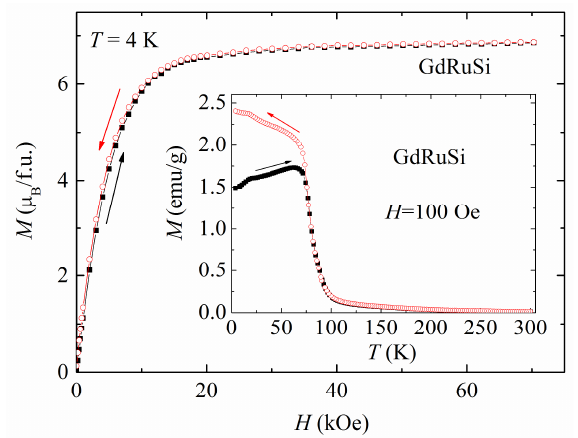
Figure 2. Magnetization and demagnetization curves of free powder sample of GdRuSi at T = 4 K. The inset shows field-cooled (FC) and zero-field-cooled (ZFC) thermomagnetic curves of GdRuSi collected in an applied field of 100 Oe applied along easy magnetization axis of the free powder sample. The zero-field-cooled thermomagnetic curve ZFC M(T) for the GdRuSi compound measured in a field of 100 Oe on free powder sample previously oriented along easy mag- netization axis by an external field of 70 kOe is presented in Figure 2. The increase in ZFC M(T) upon heating from 4 K can be caused by domain-wall movement [26]. Such an in- crease in field-cooled FC M(T) was not observed when cooling the sample in a field of 100 Oe (see Figure 2) because the maximum order degree for that magnetic field has already been reached [26]. There is no thermal hysteresis о n the M(T) dependence for GdRuSi in the region of the temperature of the magnetic phase transition of the ferro-paramagnet, i.e., this is a second-order phase transition. The Curie temperature Т С = 78.3 K of the alloys was determined from the position of the minimum of the derivative for the M(T) depend- ence. Earlier in [13] a slightly larger value of Т С = 85 K was established, perhaps because of measurements in higher field up to 15 kOe, which creates an additional ordering effect on the magnetic moments of the ions. It is also seen (Figure 2) that there is a small jump at Т ~18 K, presumably corresponding to the magnetic phase transition from antiferromag- netic to ferromagnetic ordering in the parasitic GdRu 2 Si 2 phase [27]. The presence of this phase in the GdRuSi sample was established by X-ray diffraction (see Section 3.1). There are no other features on the M(T) dependence caused by magnetic phase transformations in the GdRuSi sample. The Т С = 78.3 K for GdRuSi was also determined with the help of Arrott plots [28] as is shown in Figure 3. The positive slope of the Arrott curves indicate that the ferromagnet- to-paramagnet transition can be classified as second-order type-phase transition accord- ing to the Banerjee criterion [28]. A similar conclusion follows from the absence of thermal hysteresis о n the M(T) dependence for GdRuSi in the region of the temperature of the ferromagnet-to-paramagnet phase transition (Figure 2) and from the “caret” shape of the temperature dependence of the change in magnetic entropy – Δ S M ( T ) (see Section 3.1), which is typical of the second-order magnetic-phase transition [28].